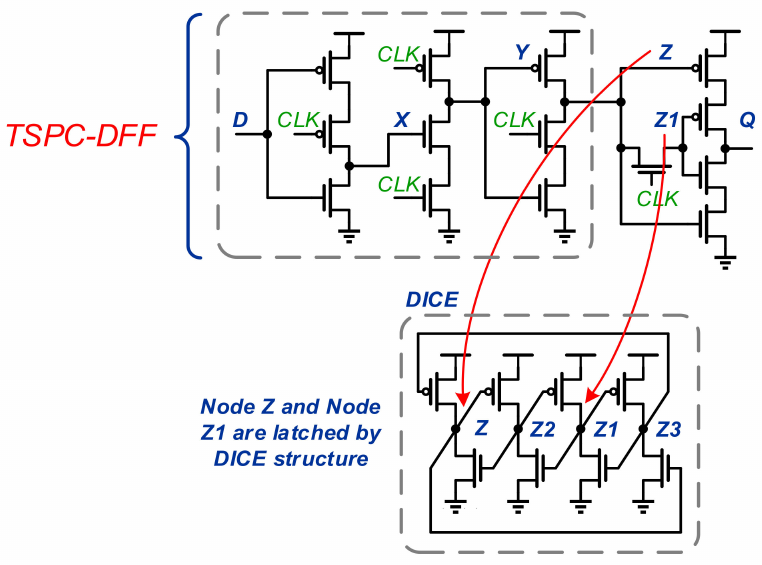
Figure 16. Schematic diagram of TSPC-DICE.